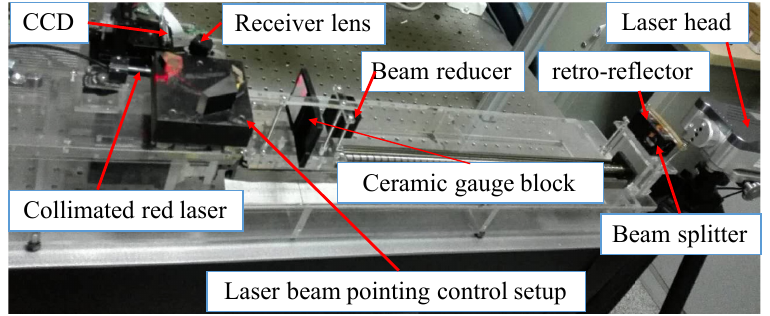
Figure 7. Calibration setup for reduction of the influence of laser beam directional dithering in a laser triangulation displacement probe.